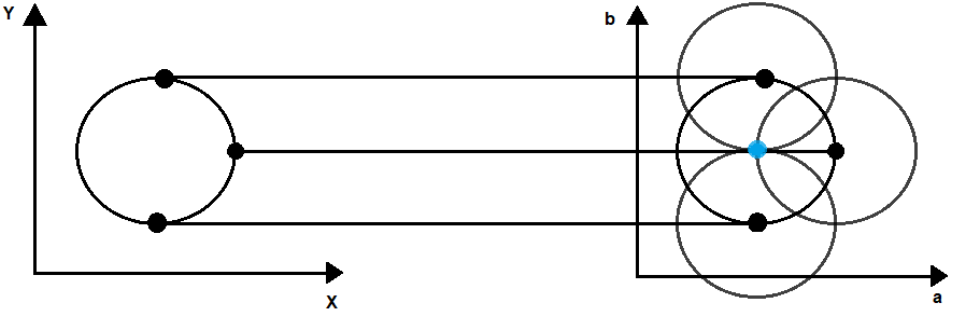
Figure 8. The Hough transform principle.